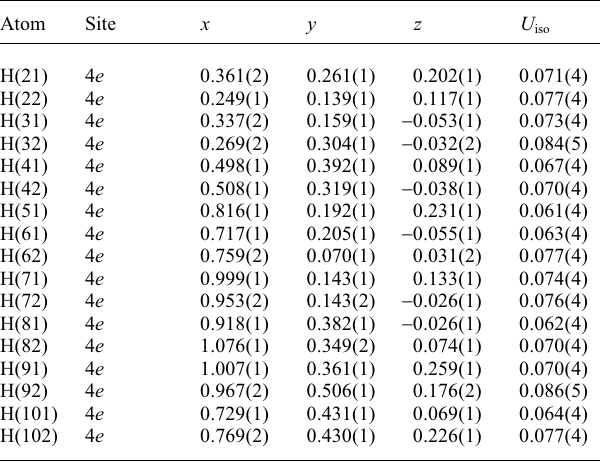
Table 2. Atomic coordinates and displacement parameters (in Å 2 )